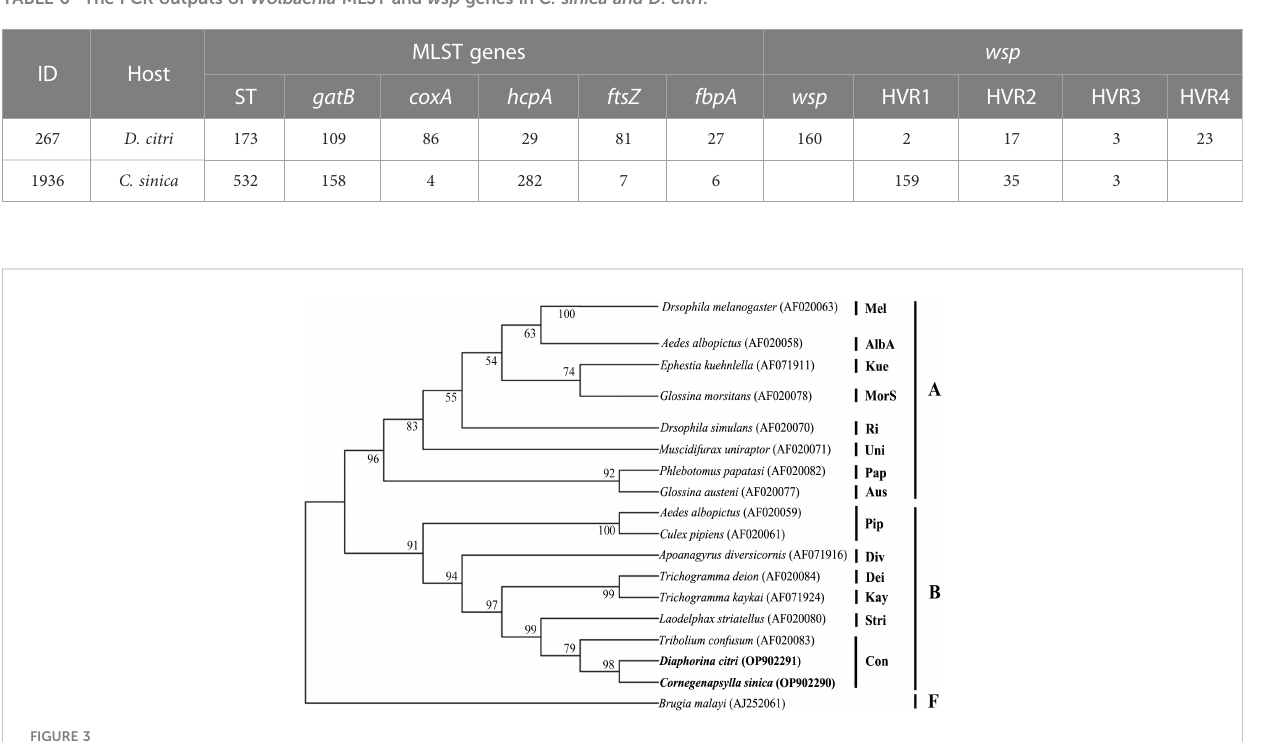
TABLE 6 The PCR outputs of Wolbachia MLST and wsp genes in C. sinica and D. citri